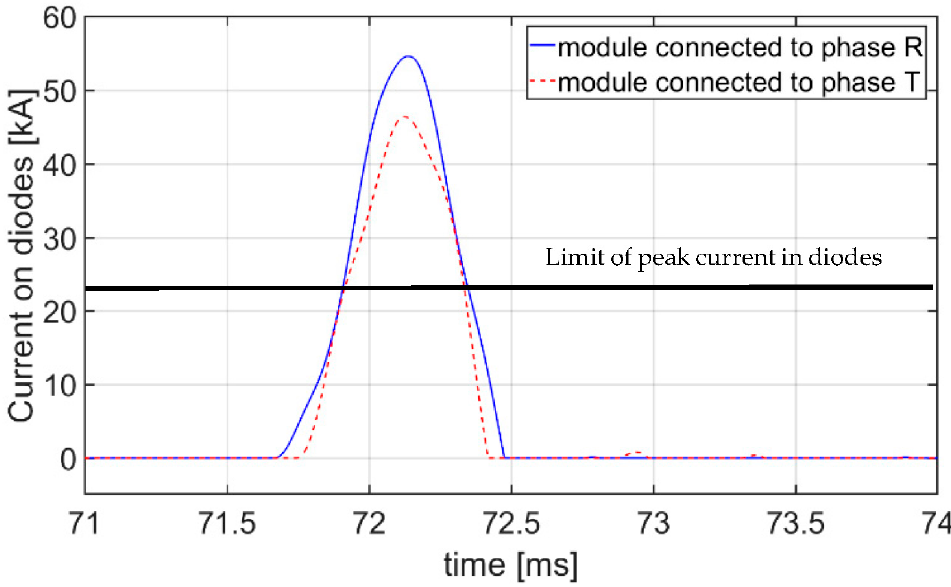
Figure 13. Voltages on the dc link, obtained from the simulation of the short circuit, without consid- ering the detachment of the flexible connection, and the voltage measurements acquired in the test.